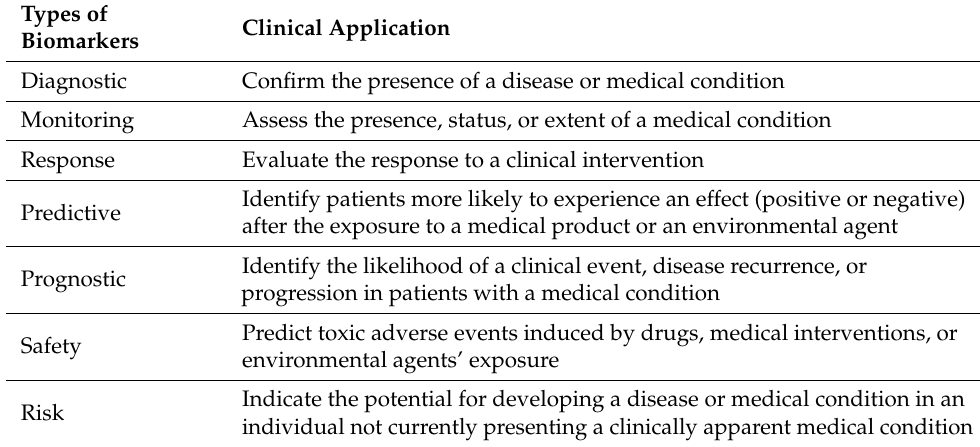
Table 1. Different types of biomarkers and their clinical application.